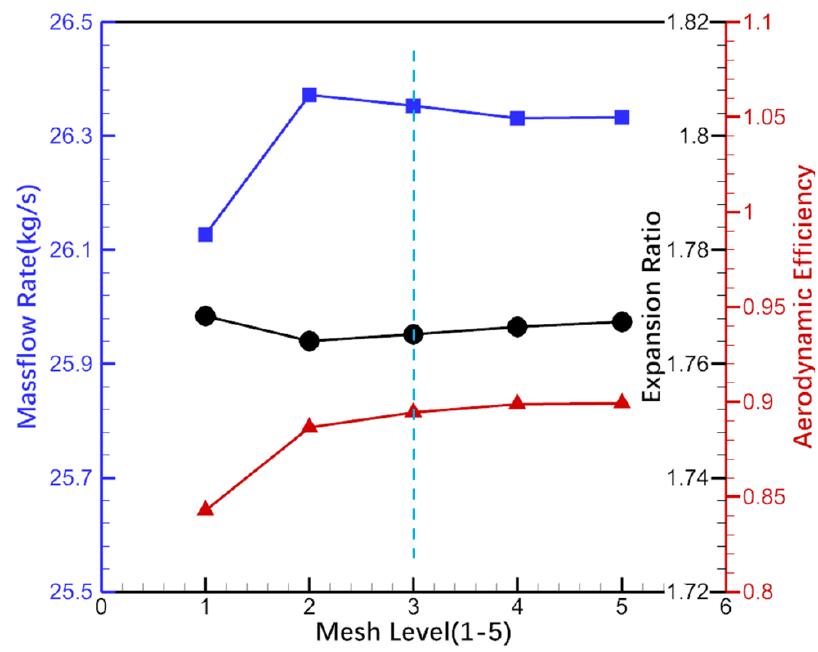
Figure 1. Comparison of aerodynamic performance at different mesh levels.